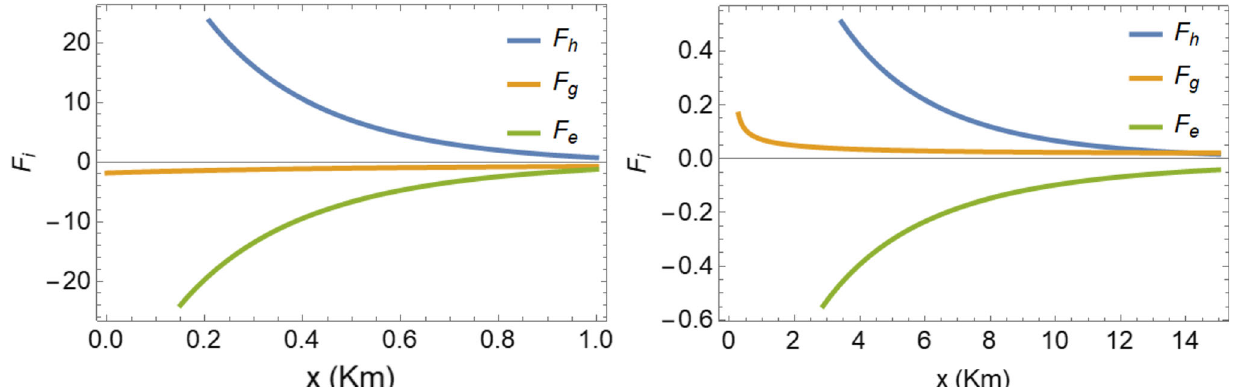
Fig. 8 The three different forces, viz. gravitational force ( F g ), hydrostatic force ( F h ) and electric force ( F e ) are plotted against x